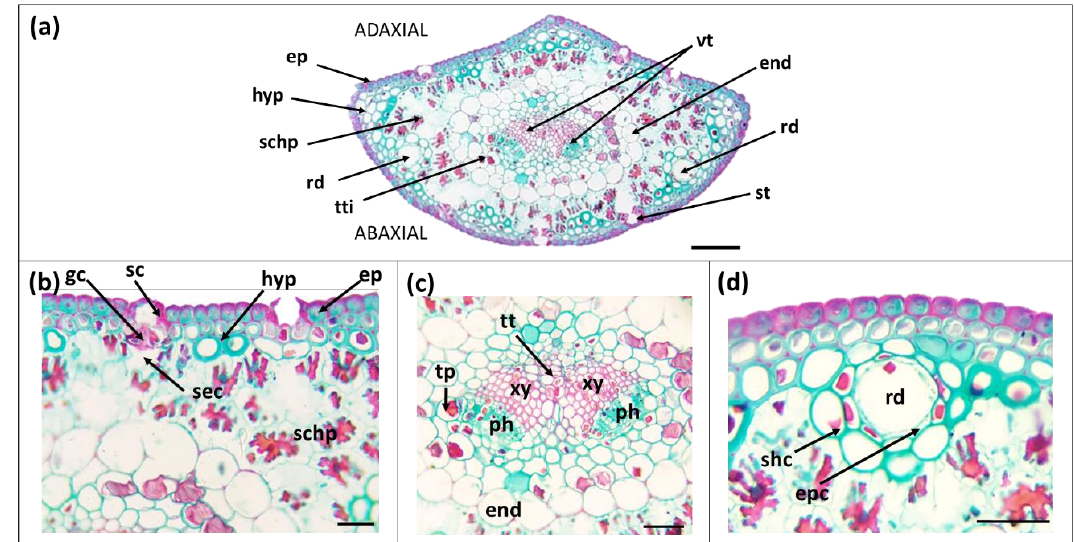
Figure 3. Stained cross-sections of Pinus canariensis secondary (adult) needles. ( a ) Whole view of the needle cross-section. ( b ) Detail of the stomata and outer tissues of the needle. ( c ) Detail of the vascular bundle and all the conductive elements. ( d ) Detail of a resin duct. Abbreviations: end, endodermis; ep, epidermis; epc, epithelial cells; gc, guard cells; hyp, hypodermis; ph, phloem; rd, resin duct; sc, subsidiary cells; schp, spongy chlorophyll parenchyma; sec, substomatal chamber; shc, sheath cell; st, stomata; tp, transfusion parenchyma; tt, transfusion tracheid; tti, transfusion tissue; vt, vascular tissue; xy, xylem. Scale bars ( a ), 50 µm, ( b – d ), 20 µm. Safranin—fast green staining.